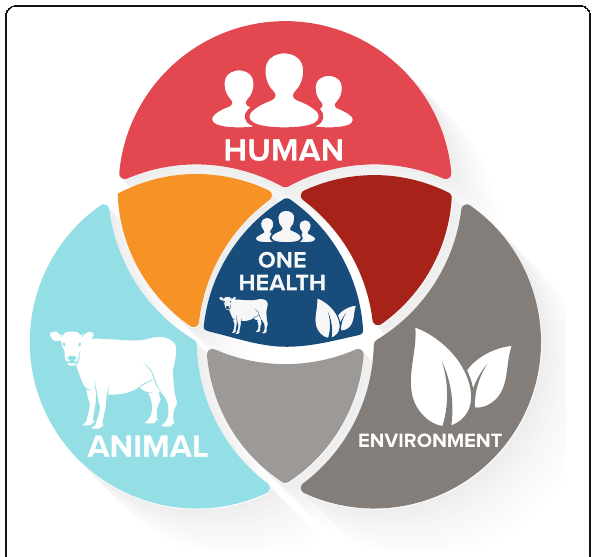
Fig. 2 Diagram of health report topics apportioned from a One Health